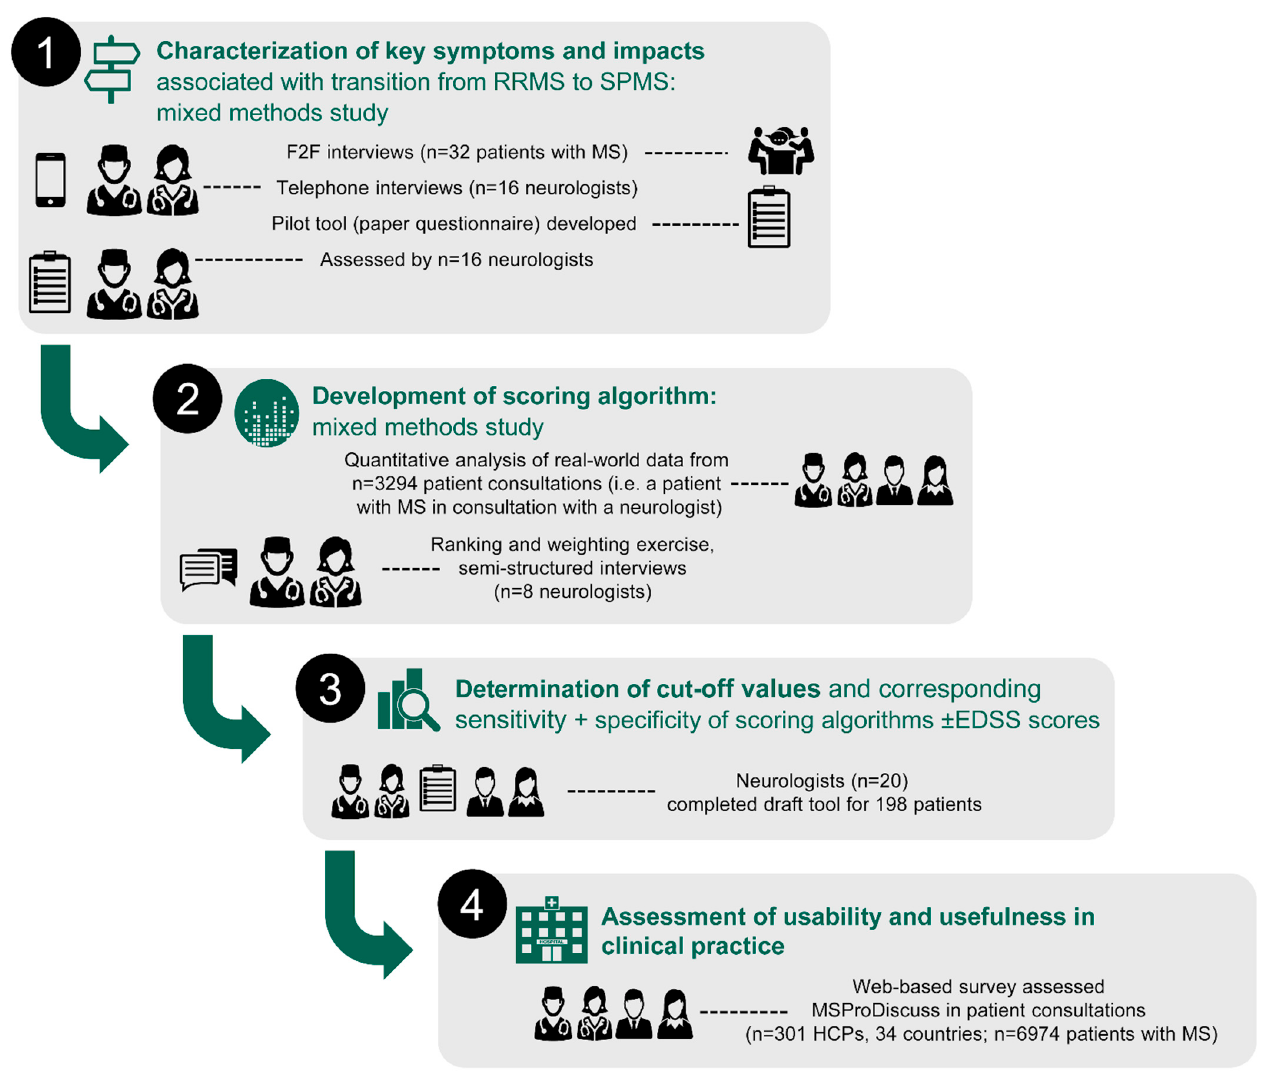
Figure 1. Stages in the development of the MSProDiscuss tool [34,38–40]. EDSS, expanded disability status scale; F2F, face-to-face; HCP, healthcare provider; RRMS, relapsing–remitting MS; SPMS, secondary progressive MS.